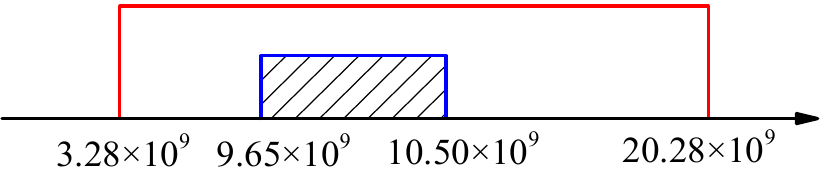
Figure 9. Comparison of bending stiffness and its ultimate value at interval (unit: N·m 2 ).